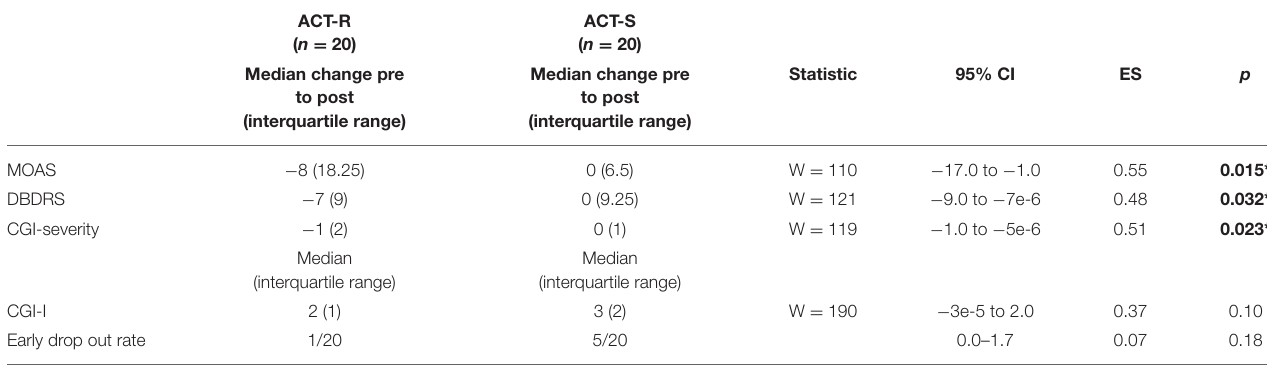
TABLE 2 | Pre-post treatment changes in outcomes.